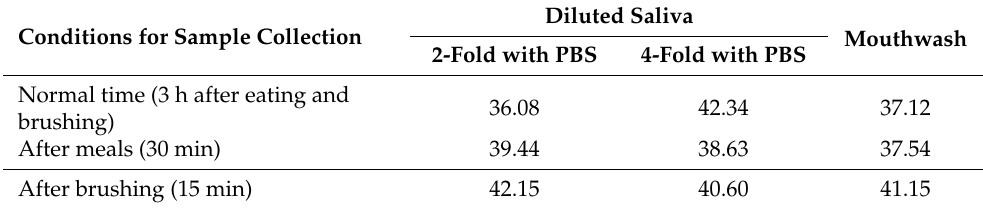
Table 6. Effect of diet and brushing (Ct